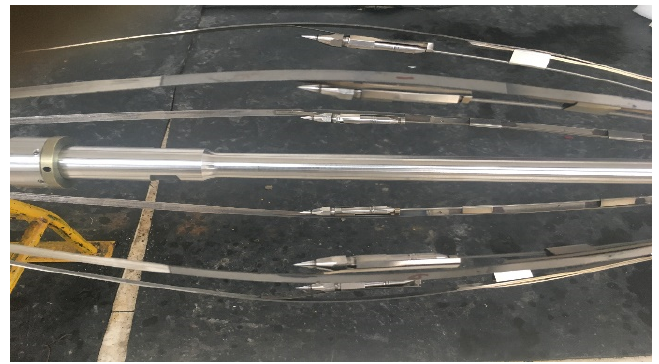
Figure 1. Structure diagram of Gas Array Tool (GAT)